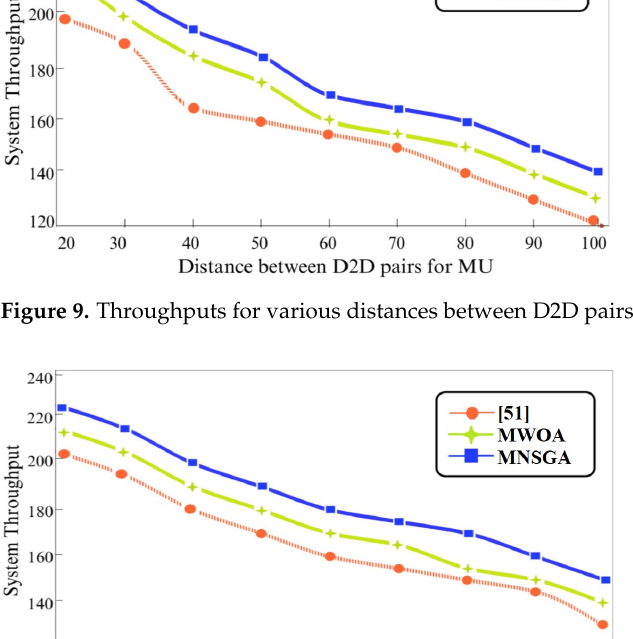
Figure 11. Overall throughputs for various distances between D2D pairs. 5.4. Throughput Analysis for Various Distances Figures 12–14 show the system throughputs for various minimum data rate re- quirements of users for MU s, DU s, and overall users. When the minimum rate condi- tion of entities is maximized, ranging from almost 500 kbps up to 3000 kbps, throughput reduces for all schemes, as shown in the figures. For maintaining the minimum re- quired rate of users, the proposed MNSGA scheme outperforms MWOA and the algo- rithm from [51]; MWOA outperforms the algorithm from [51]. In Figure 12, the sys- tem throughputs of the MNSGA, MWOA, and [51] algorithms are compared in terms of the minimum required rate for MU s. In Figure 13, the MNSGA, MWOA, and [51] algorithm system throughputs are compared in terms of the minimum rate of DU s.